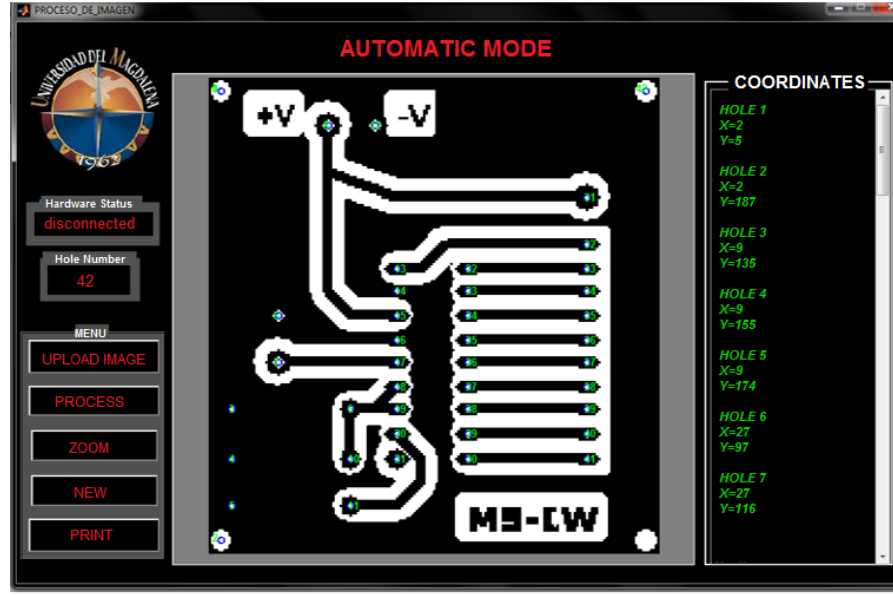
Figure 12. Graphic user interface in automatic mode.